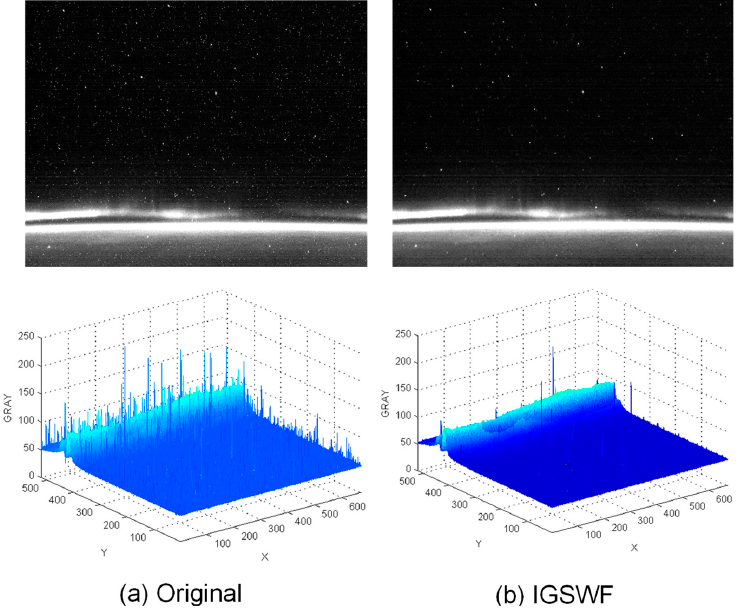
Figure 11. Comparison before and after denoising in SAA area 1: ( a ) the star image and the three ‐ dimensional distribution of the grayscale before denoising; ( b ) the star image and the three ‐ dimensional distribution of the grayscale after IGSWF processing.